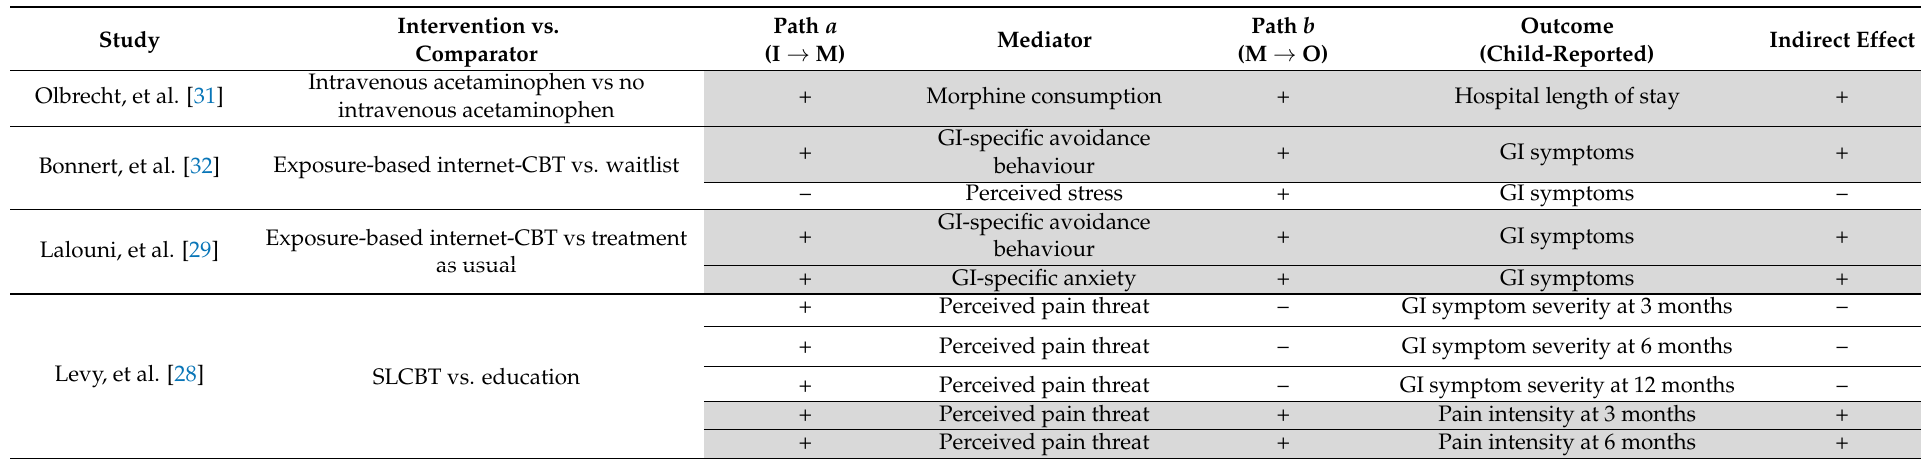
Table 3. Summary of mediation models assessed in included